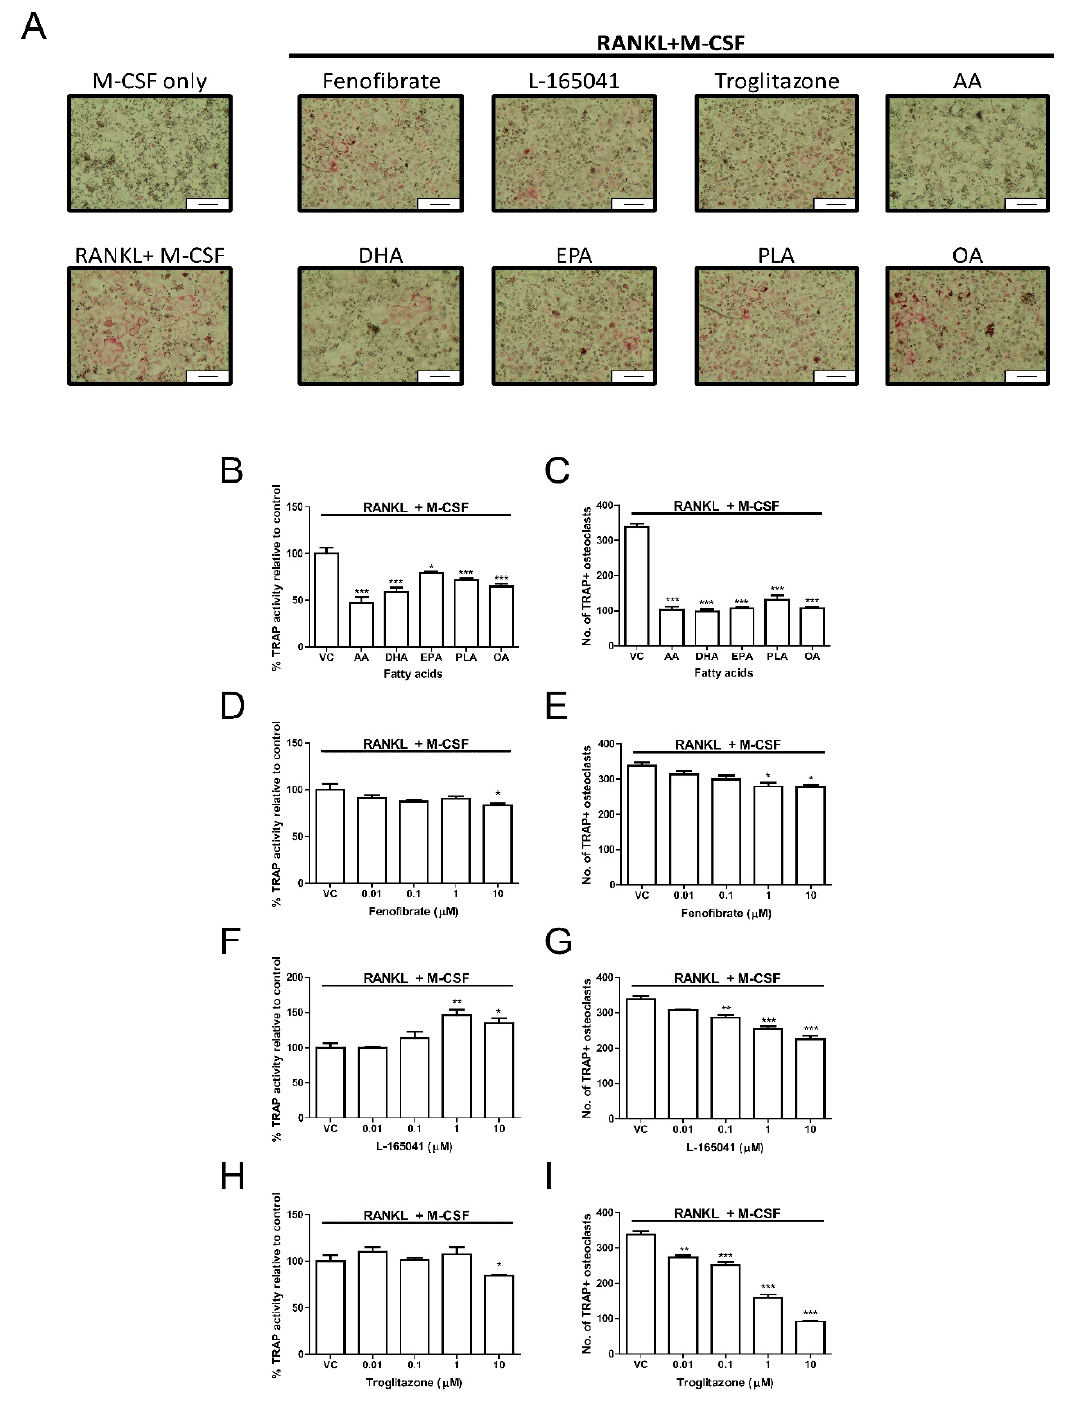
Figure 4. E ff ect of PPARs and UFAs on osteoclastogenesis. CD14 + monocytes were seeded into 96-well plates and exposed to PPAR agonists (10 µ M) or UFAs in the presence of RANKL (30 ng mL − 1 ) and M-CSF (25ng mL − 1 ). ( A ) Cells were stained for tartrate resistant acid phosphatase (TRAP) and then visualized under a light microscope. TRAP positive cells appear pink. Scale bar = 0.2 mm. ( B,D,F,H ) TRAP activity was measured in the conditioned media using p-NPP as a substrate. ( C,E,G,I ) Quantification of TRAP positive osteoclasts. TRAP positive osteoclasts with three or more nuclei were counted. VC: vehicle control. * p < 0.05, ** p < 0.01, *** p < 0.001 vs. vehicle control.